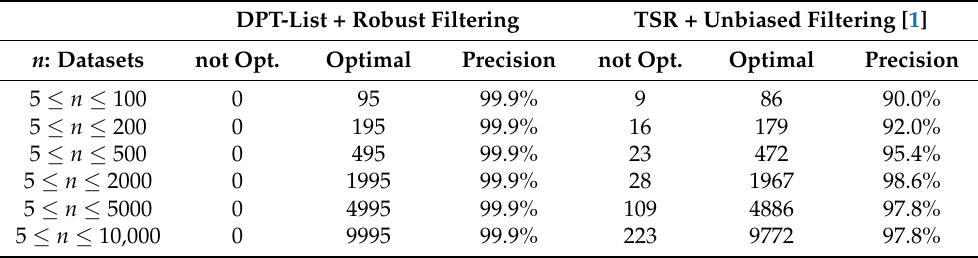
Table 3. Optimal precision of the DPT-List TSR + robust filtering ( n ≤ 10,000). DPT-List + Robust Filtering TSR + Unbiased Filtering [1]